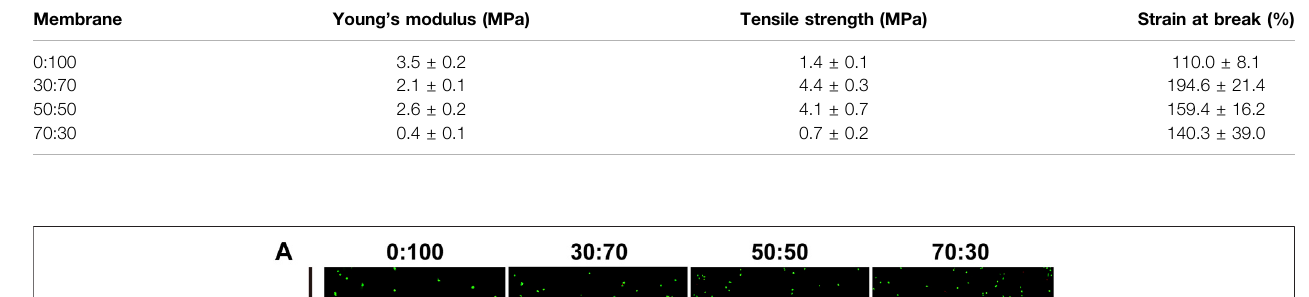
Frontiers in Bioengineering and Biotechnology |